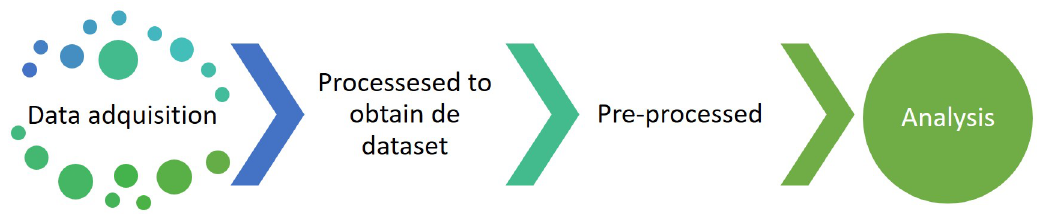
Figure 1. Flowchart of the methodology followed.